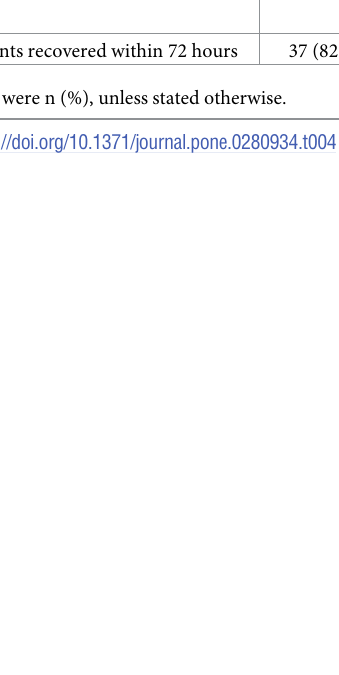
Table 4. Regression analysis for categorical outcome. Characteristics